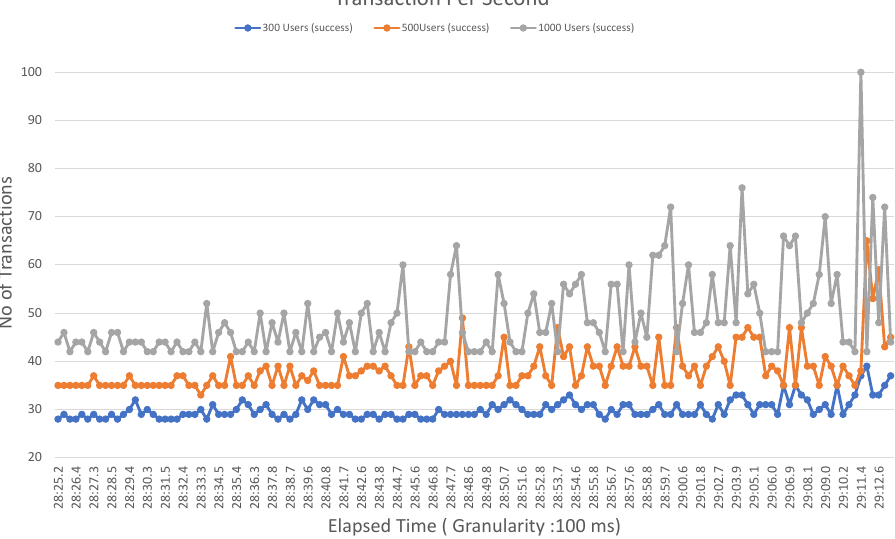
Figure 14. Transactions per